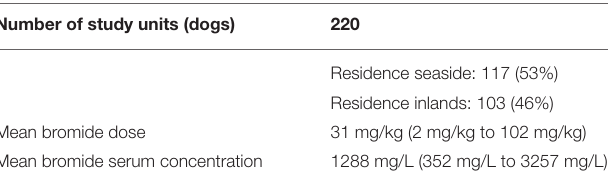
TABLE 1 | Baseline data of the study population.